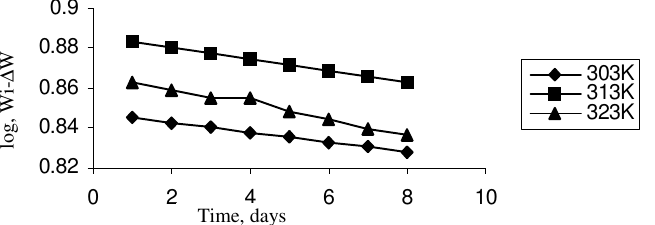
Figure 10. Variation of log (Wi - ∆ W) with time (days) for mild steel coupons in 2 M HCl solution at different temperatures without inhibitor.